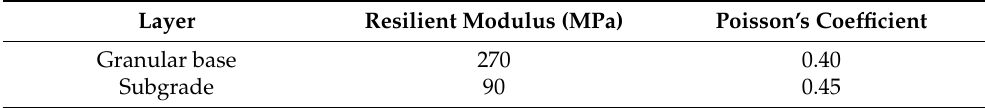
Table 5. Base and subgrade parameters (based on